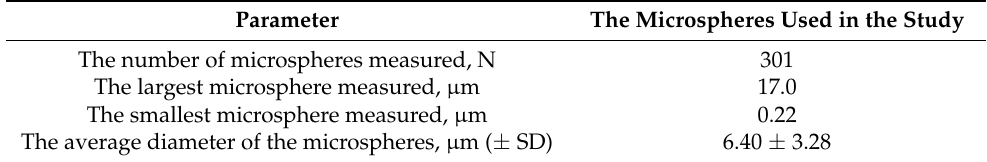
Table 1. SVPLA particles chart. Parameter The Microspheres Used in the Study The number of microspheres measured, N 301 The largest microsphere measured, µ m